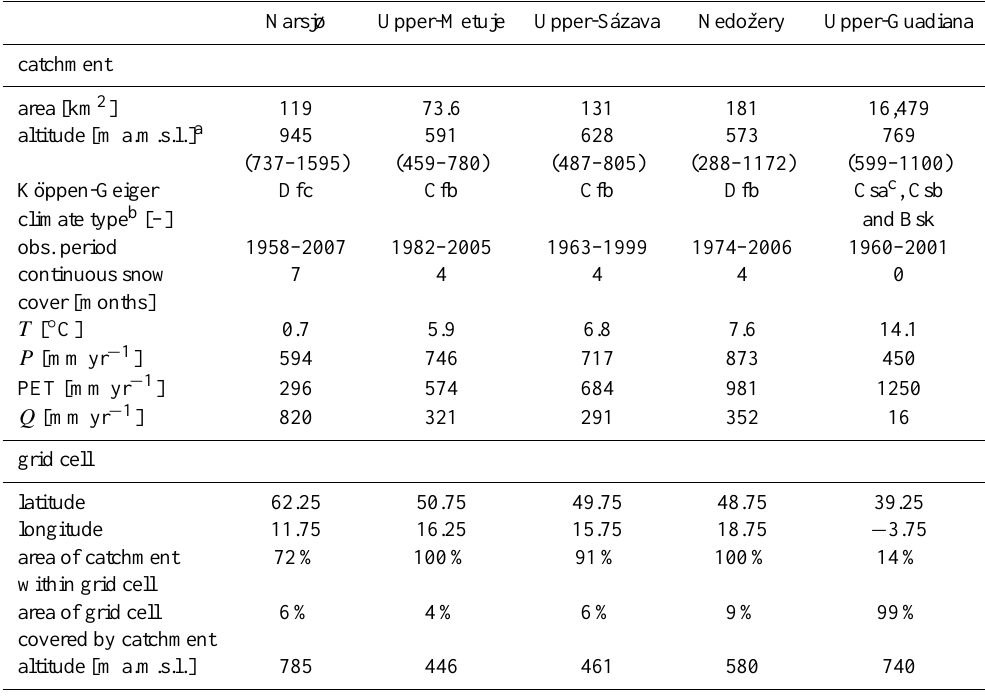
Table 2. Catchment characteristics of the selected catchments Narsjø (Norway), Upper-Metuje and Upper-S´azava (Czech Republic), Nedoˇzery (Slovakia), and Upper-Guadiana (Spain); obs. period = observation period, T = temperature, P = precipitation, PET = potential evaporation, Q = discharge. Narsjø Upper-Metuje Upper-S´azava